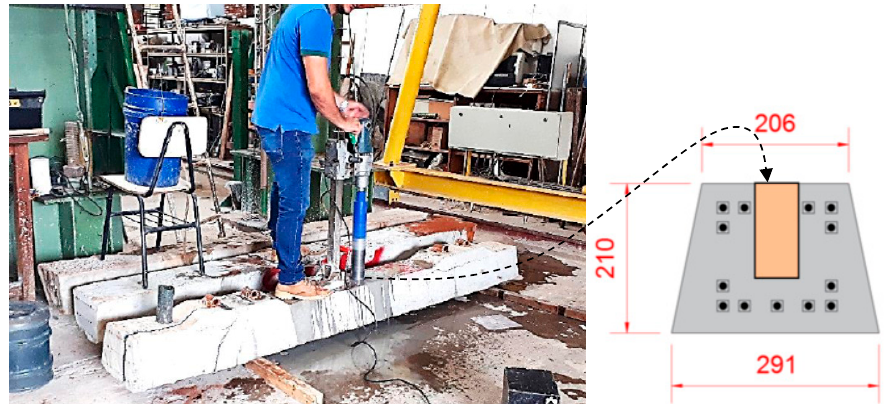
Figure 2. Execution of specimen extraction for concrete testing.